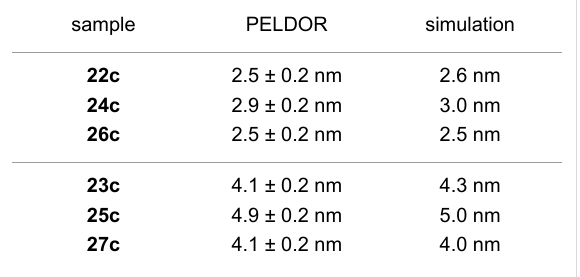
Table 1: Spin–spin distances in oligonucleotides 22c–27c determined by PELDOR and by molecular modelling. The predicted distance is an average of N–N, N–O, O–N, and O–O